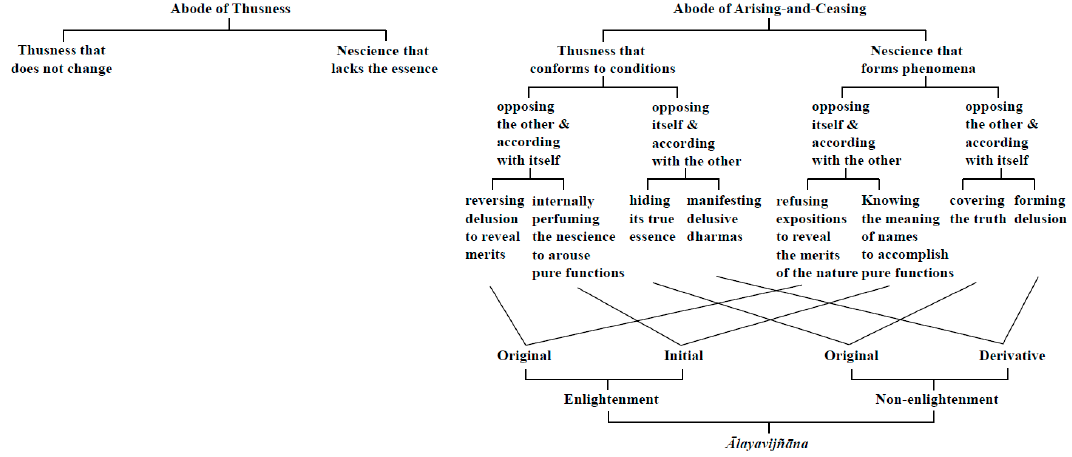
Figure 1. The unification of truth and delusion in Fazang’s commentary of the Awakening of Faith 39 .